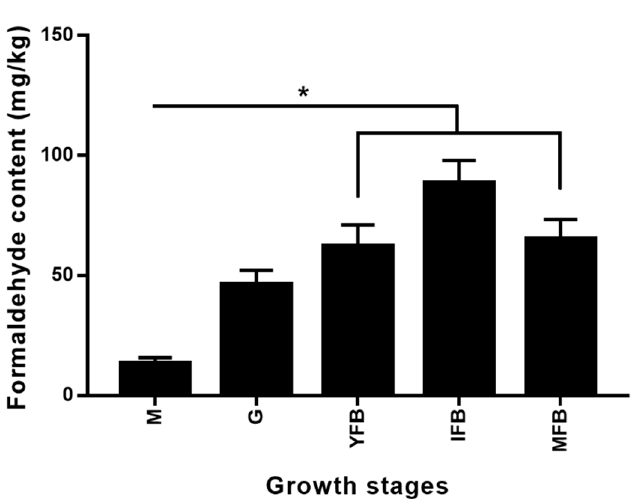
Figure 5. Endogenous formaldehyde content of L. edodes strain W1 at different growth stages. M, mycelia; G, grey; YFB, young fruiting body; IFB, immature fruiting body; MFB, mature fruiting body. Error bars indicate standard deviation for three independent experiments. * p < 0.05, ANOVA tests by Duncan’s indicate significant differences.